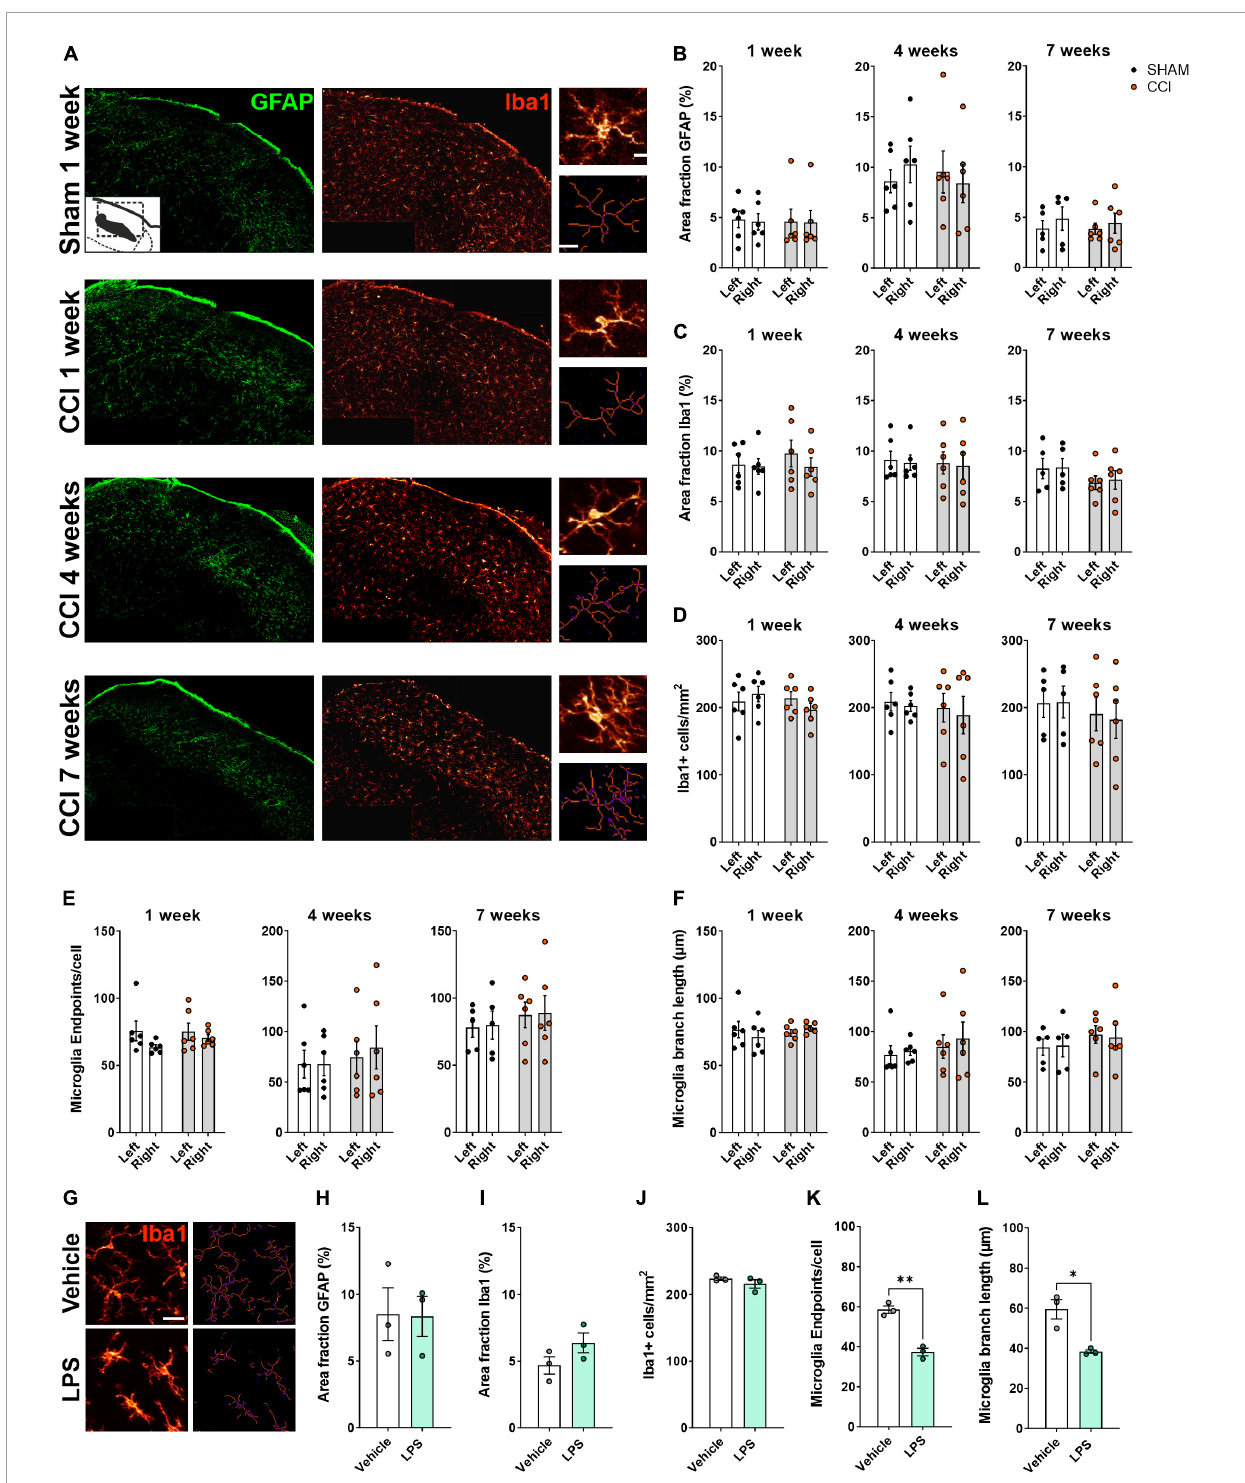
FIGURE3 Glial activation was not detected in the LPBN of rats following CCI surgery. (A) Representative images of the right LPBN, showing immunohistochemical staining for the astrocytic marker GFAP (green) and the microglial marker Iba1 (red). Insets on the right show high-magnification images of microglial cells (top), and the corresponding skeletons (bottom) used for quantitative evaluation of microglia morphology. Scale bars: 100 µ m for overview images, 10 µ m for inset. (B,C) Immunofluorescence density (Area fraction) of GFAP (B) and Iba1 (C) at 1, 4, and 7 weeks following surgery. (D–F) Quantification of microglial cell number per mm 2 (D) and microglial morphology (E,F) revealed no changes at 1, 4, or 7 weeks following surgery. n = 6 rats per treatment, 3–4 slices per animal. (G–N) A systemic inflammatory challenge induces detectable microglial activation in the LPBN. (G) Representative images of Iba1+ cells (left) and the corresponding skeletons (right) following i.p. administration of LPS (5 mg/kg) or vehicle. Scale bar: 25 µ m. LPS did not affect GFAP (H) or Iba1 (I) immunofluorescence density and microglial cell density (J) , but significantly reduced the number of extremities [endpoints, (K) ] and the average branch length (L) in microglia cells. ∗ p < 0.05 and ∗∗ p < 0.01, n = 3 rats per treatment, 3–4 slices per animal, average of left and right